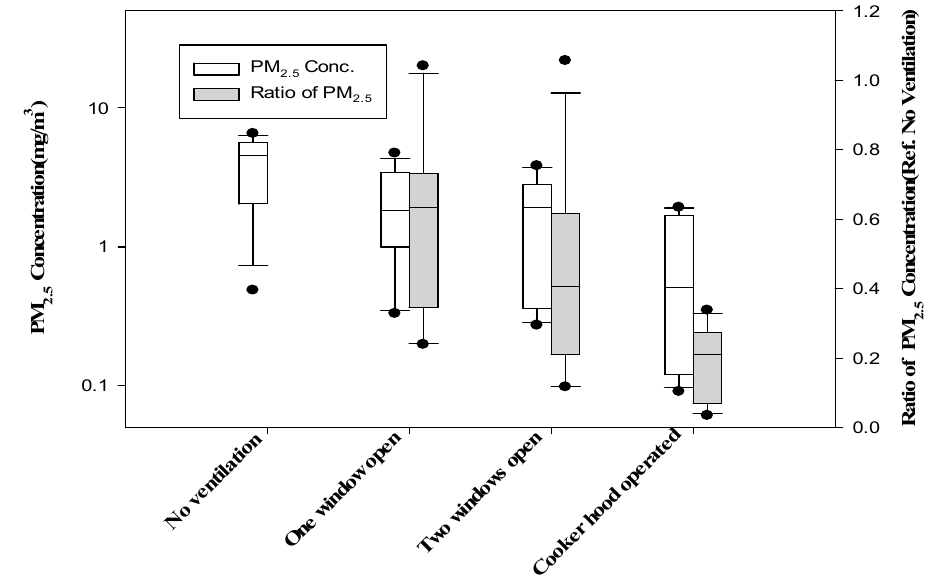
Figure 2. Distributions of median indoor particulate matters with a diameter of 2.5 micrometers or less (PM 2.5 ) concentrations obtained at each sampling site according to ventilation condition and distribution of ratios of PM 2.5 concentrations obtained with ventilation, to those without ventilation; Concentrations were lower than the reference ( p < 0.05).